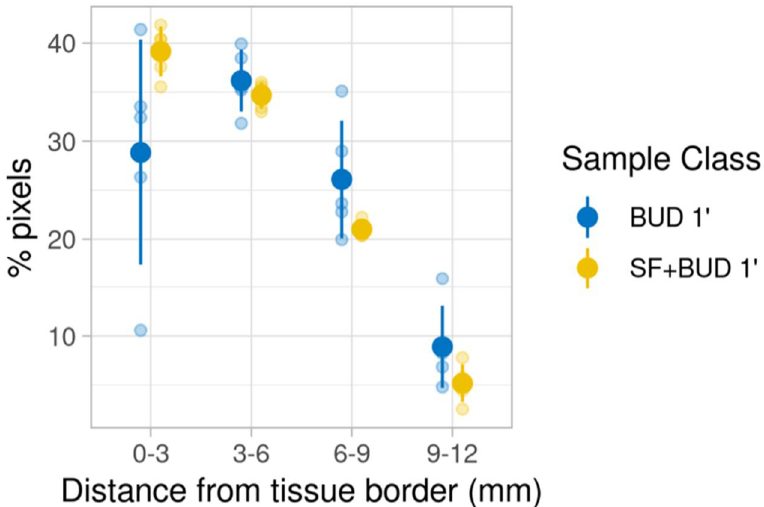
Figure 5. Distribution of the pixels belonging to the 4th intensity quartile of the budesonide signal as a function of their distance from the tissue border. In blue, data from lambs receiving intratracheal budesonide alone (0.25 mg/kg); in yellow, data from lambs receiving budesonide (0.25 mg/kg) combined with surfactant (200 mg/kg). No statistical differences were noted between groups; at 0–3 mm from the tissue border, p = 0.09; at 3–6 mm, p = 0.6; at 6–9 mm, p = 0.15; at 9–12 mm, p = 0.09; Wilcoxon rank sum test.